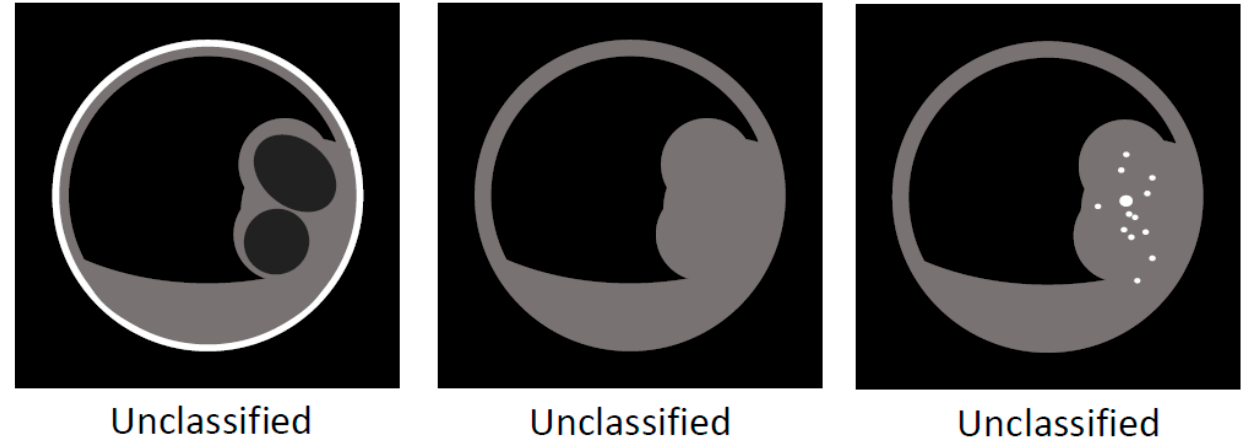
Figure 12. Schema of CT findings in a localized type of IgG4-sclerosing cholecystitis: others (not classified).